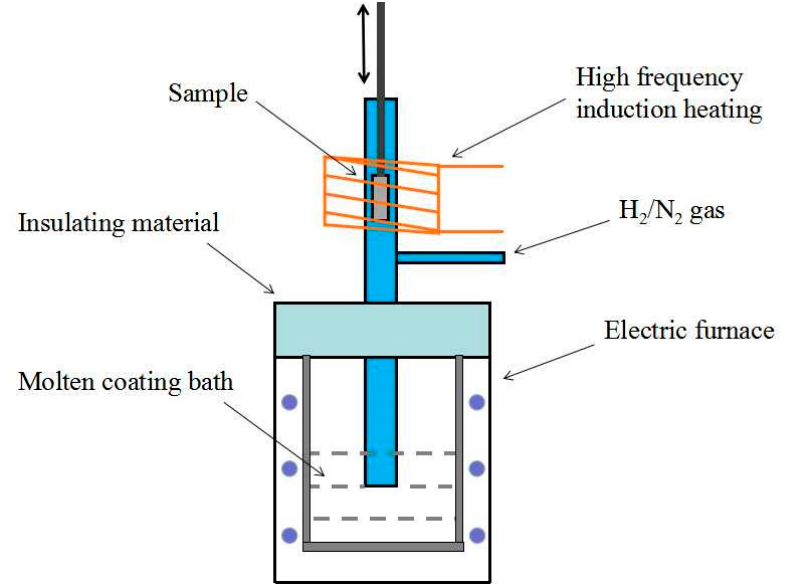
Figure 1. Schematic diagram of hot dipping simulator.